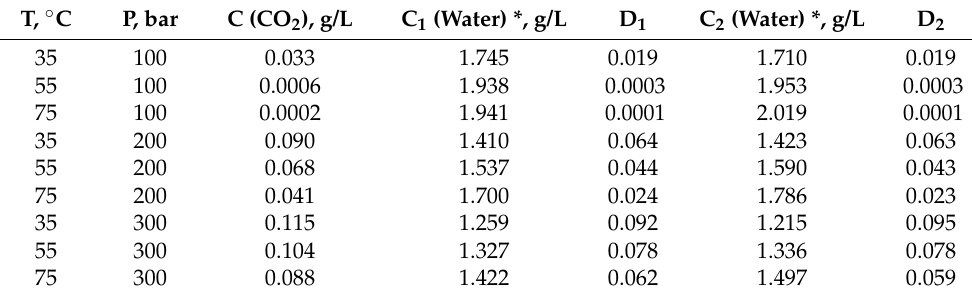
Table 2. Distribution of caffeine in a two-phase water–PEG–supercritical (SC) CO 2 system at different pressure and temperature values. Initial concentration of caffeine in water–PEG solution is 1.942 g/L. T, ◦ C P, bar